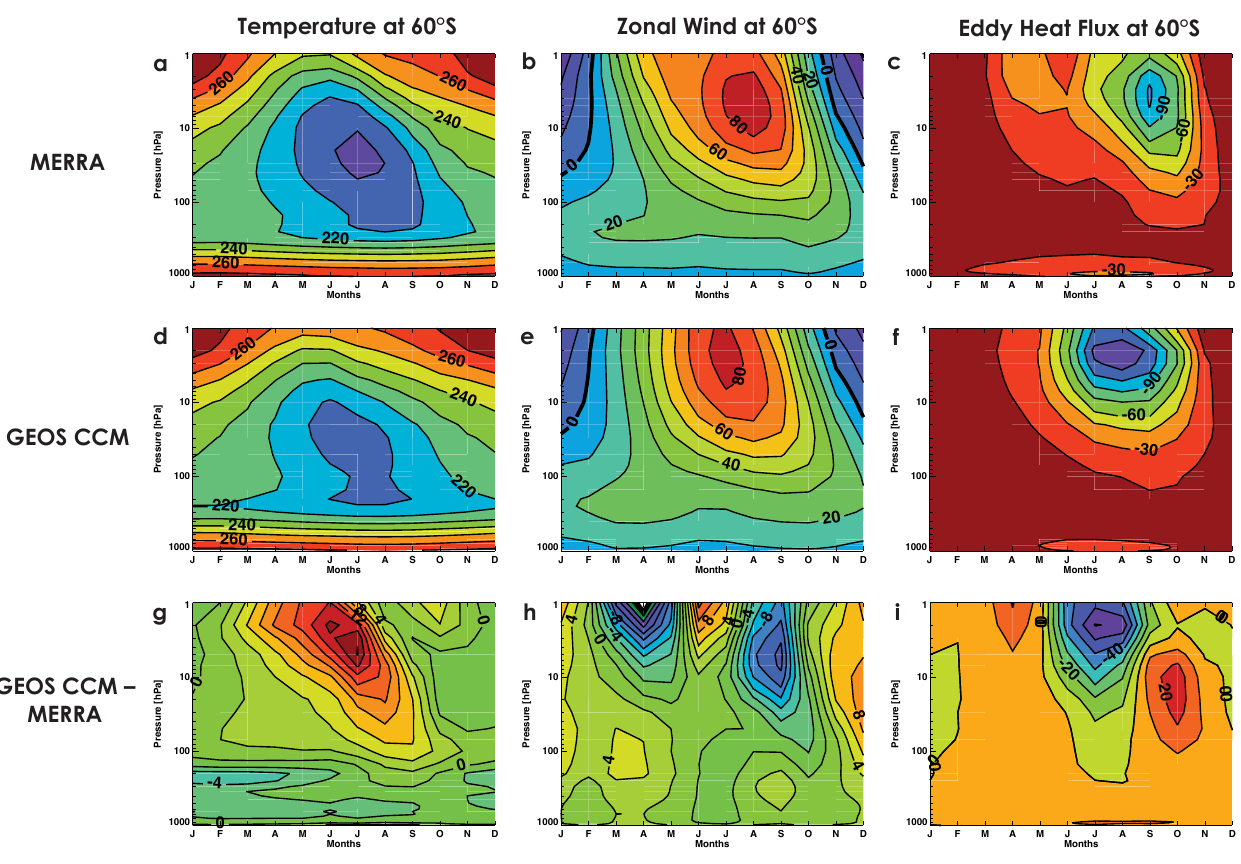
Fig. 1. Temperature (K) (a, d, g) , zonal wind (m s − 1 ) (b, e, h) and meridional eddy heat flux (Kms − 1 ) (c, f, i) at 60 ◦ S, as a function of month and altitude, in (a, b, c) a composite of ENSO neutral years in the MERRA reanalysis, (d, e, f) the ENSON simulation, and (g, h, i) differences between the ENSON simulation and